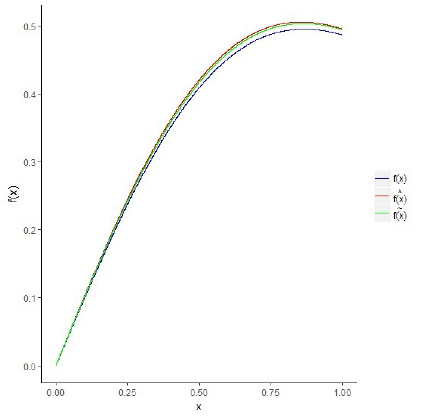
Figure 2 – MLE and UMVUE of sampled pdf.